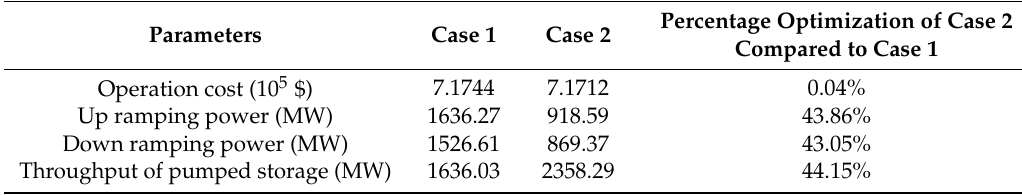
Table 4. Results comparison of Case 1 and Case 2